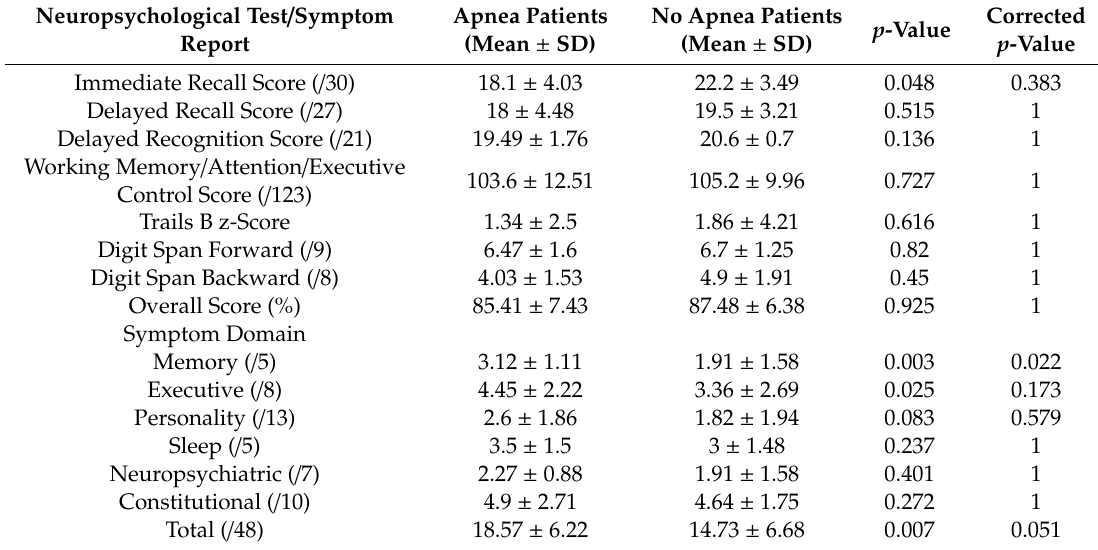
Table 2. Neuropsychology test scores and post-concussion syndrome (PCS) symptoms of all study